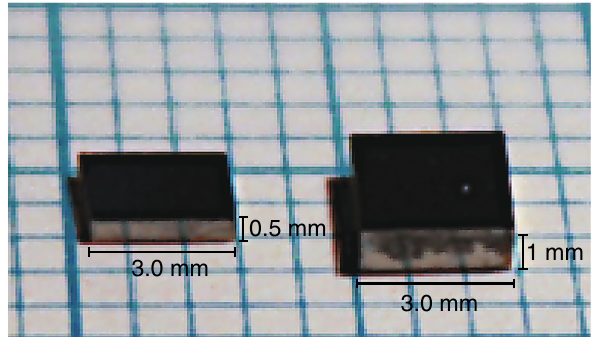
0.5 mm 1 mm 3.0 mm 3.0 mm Fig. 9 Ge Neutron Transmutation Doped sensors for ZnSe (right) and light detector (left). The dimensions for the two sensors are 3 × 2.8 × 1 mm 3 and 2 × 2.8 × 0.5 mm 3 ,